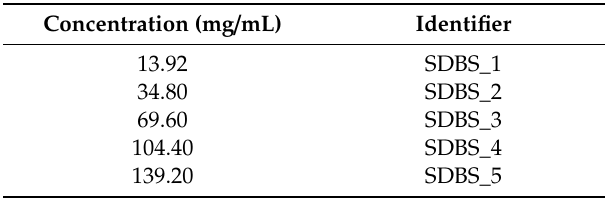
Table 3. Identifier for di ff erent